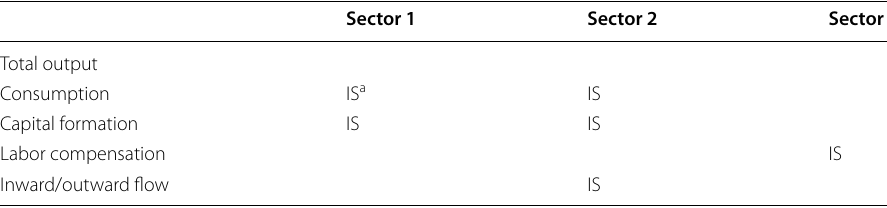
Table 3 An example of IS indicator in an imaginary nation